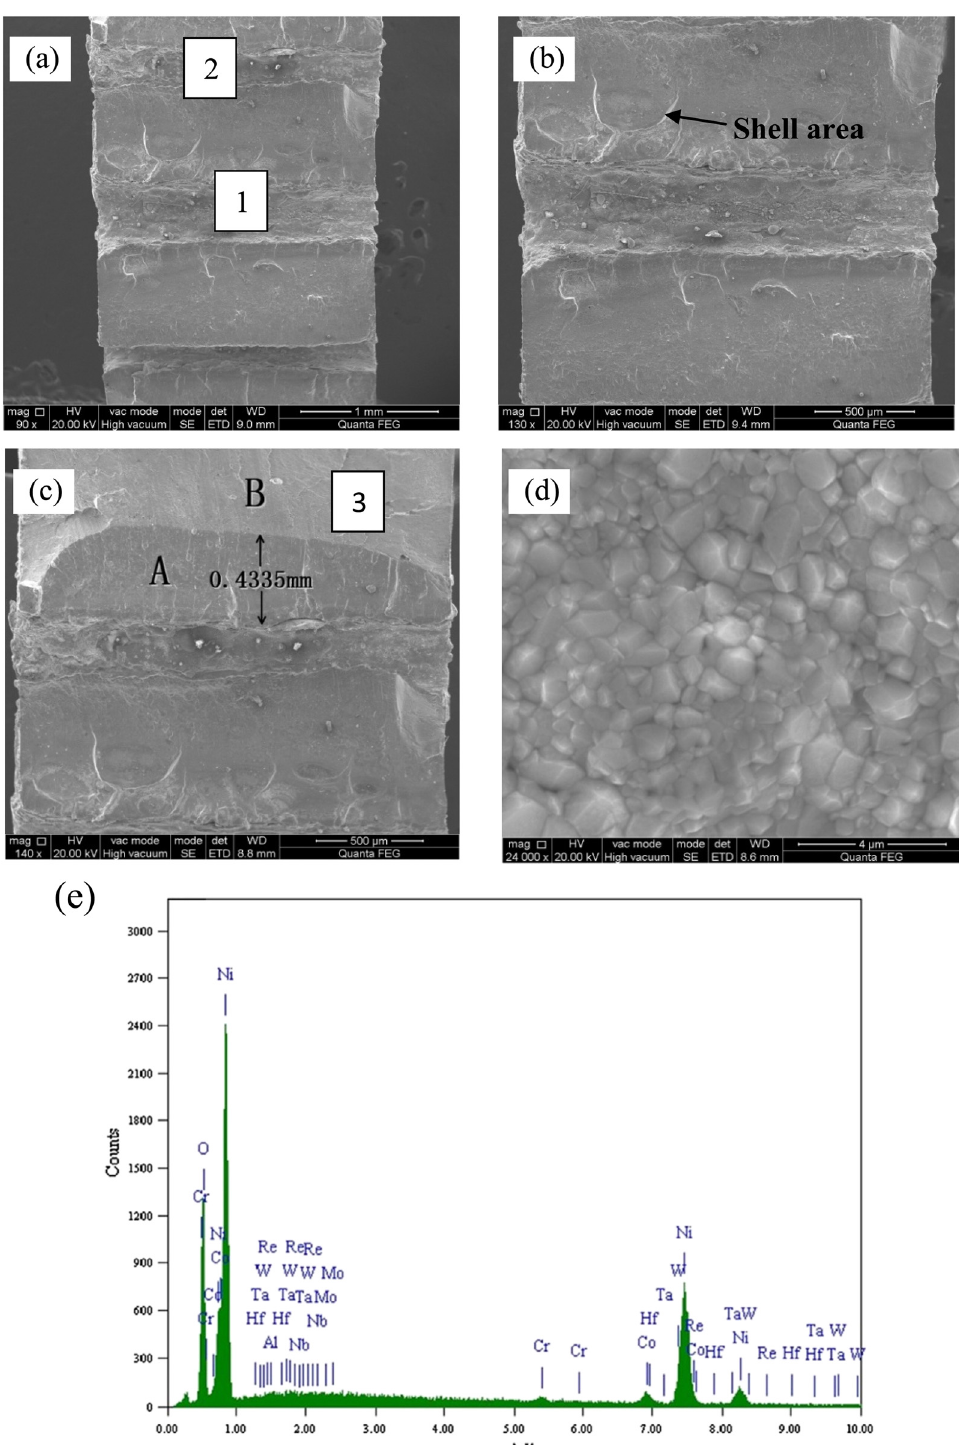
Figure 7: Fracture morphology of MSLD: ( a ) macroscopic fracture morphology, ( b ) middle hole fracture morphology, ( c ) edge hole fracture morphology, ( d ) shell area, and ( e ) the EDS analysis of